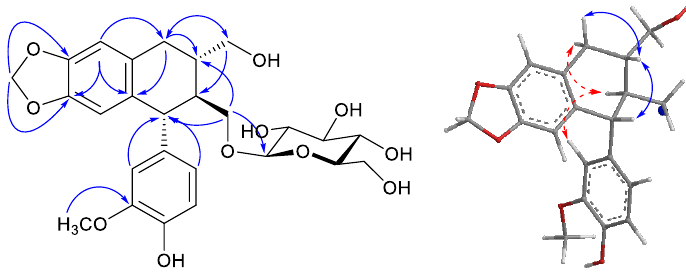
Figure 2. Key HMBC and NOESY correlations of compound 1 .